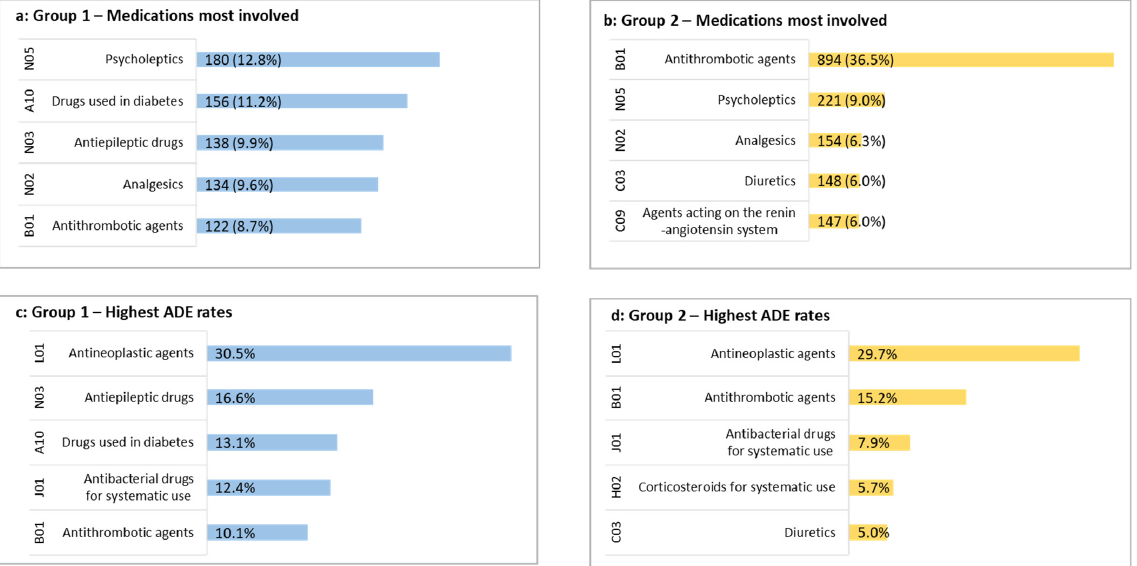
Figure 2. Lists of the top 5 medications most involved in ADEs and with the highest ADE rates. For medications most involved ( a , b ) data are presented as n (% of all medications involved in an ADE) for patients being less than 65 years ( a ) and more than 65 years ( b ), categorized by ATC class level 2. Medications ADE rates were determined by dividing the number of times a medication was involved in an ADE by the total number of prescriptions for that medication among included patients.